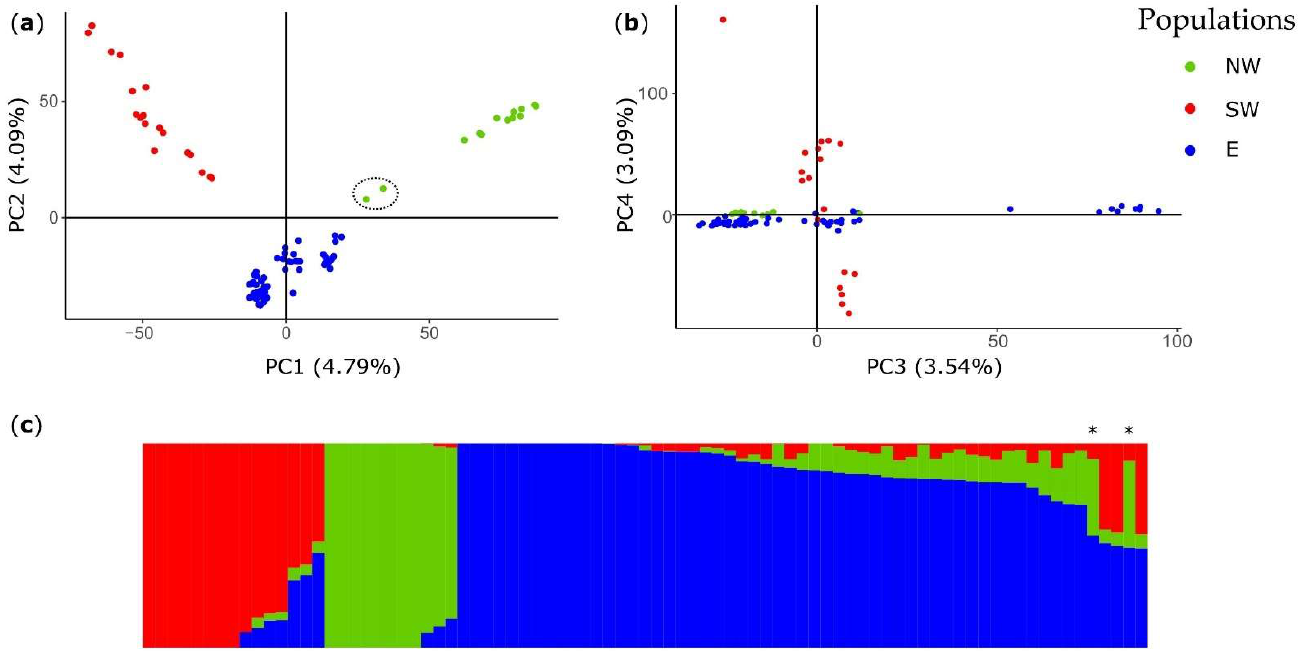
Figure 2. Population structure of 83 Sardinian wild boar. ( a – b ) First four axes from principal component analysis (PCA), with the percentage of variance summarized by each axis in parentheses. PC1 and PC2 describe the strongest pattern in the data, while PC3 and PC4 describe finer differentiation within the southwestern and eastern clusters; ( c ) individual assignment to three genetic clusters according to ADMIXTURE analysis. The two individuals from Nurra that were removed from subsequent analyses are circled in Figure 2a to highlight their positioning with respect to the northwestern and eastern subpopulations, and flagged with an asterisk in Figure 2c.